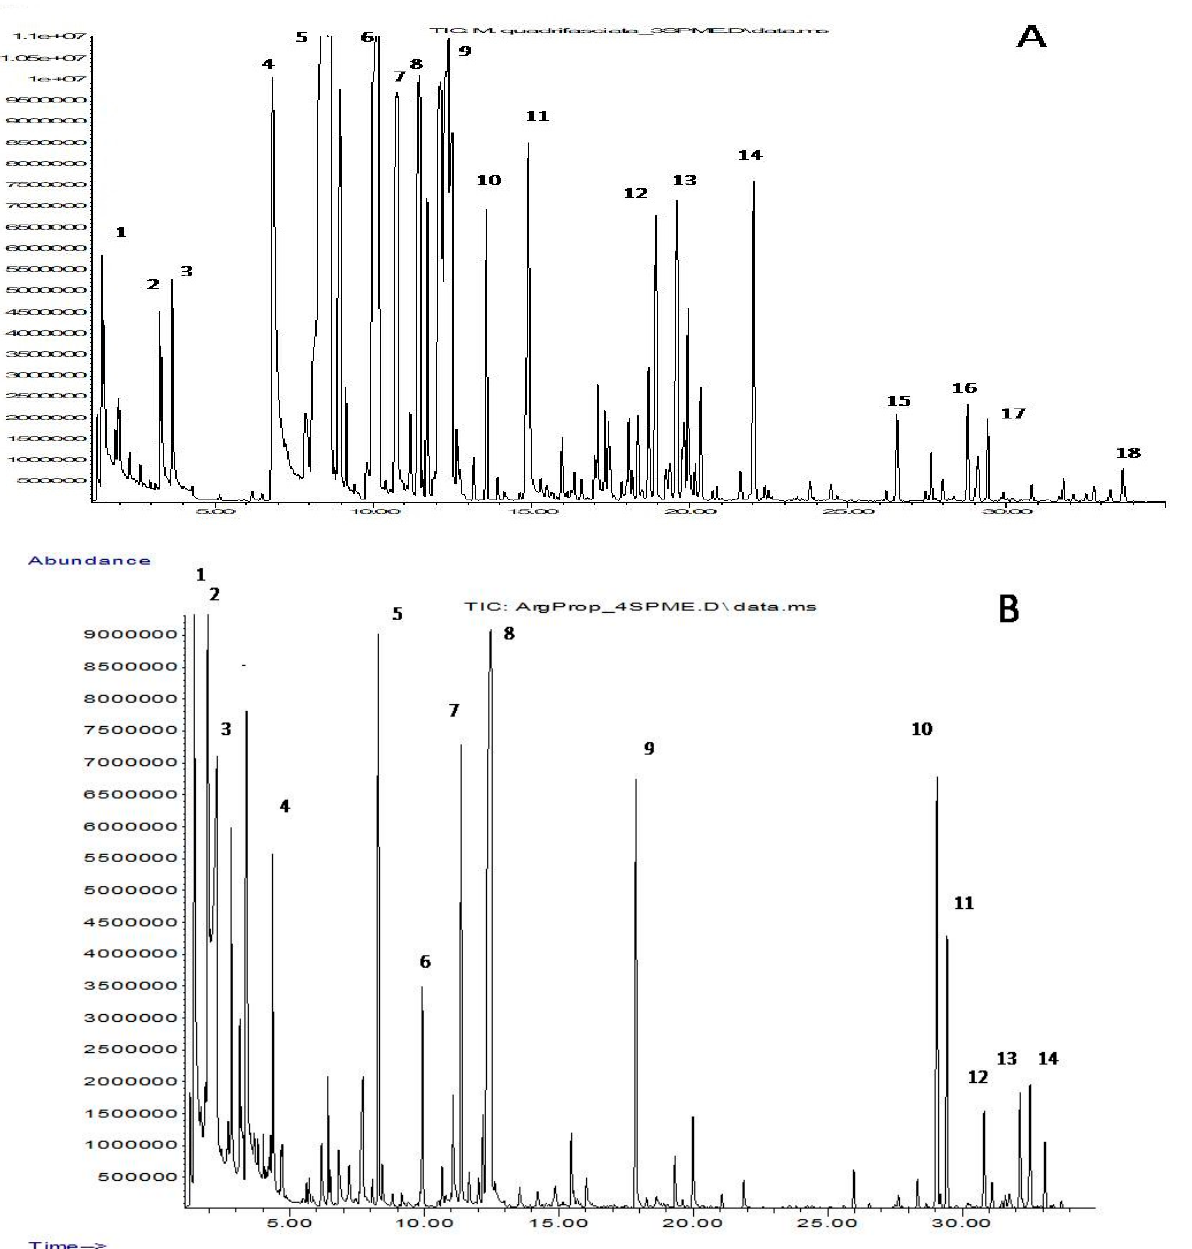
Figure 1. Chromatogram of the volatile components in propolis M. quadrifasciata ( A ) and T. fiebrigi ( B ). ( A ) 1—ethanol, 2—pyridine, 3—toluene, 4—styrene, 5— α -pinene, 6— β -pinene, 7—myrcene,